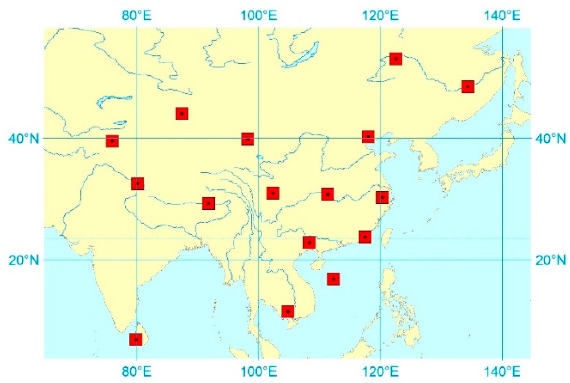
Figure 1. The location of 16 very low-frequency (VLF) band detection sites (shown as red squares) as of mid-December 2019. Each red box represents a site.